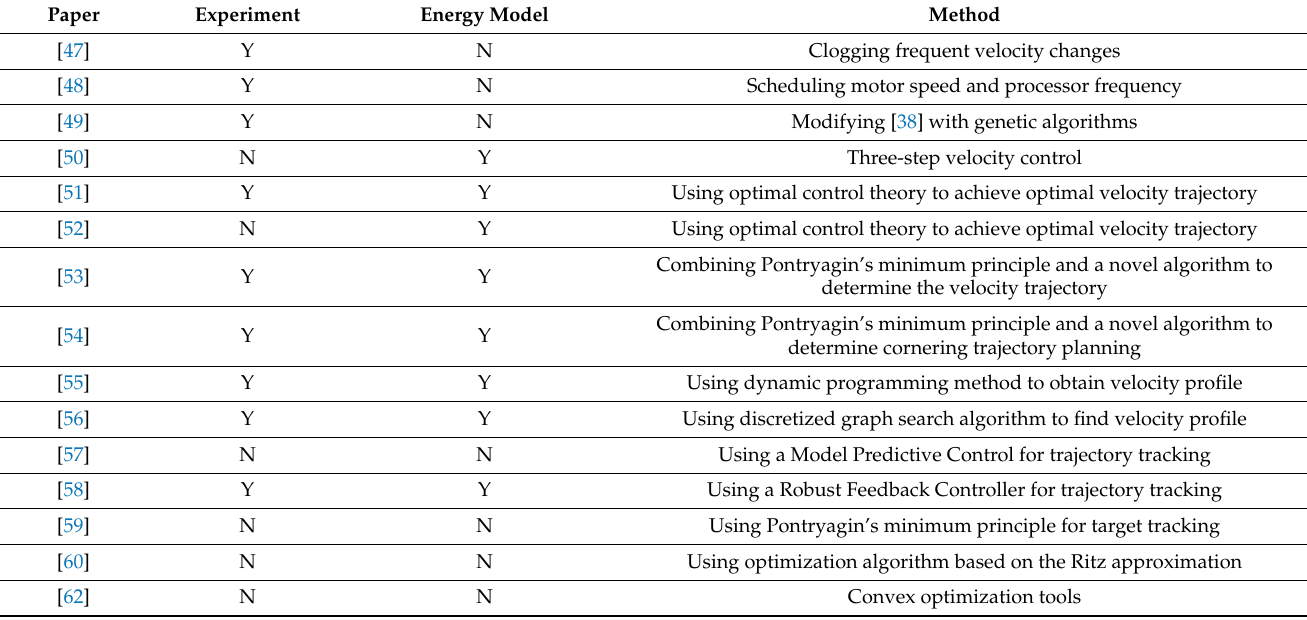
Table 2. Overview of papers on motion control related to energy with a summary of the methods used.